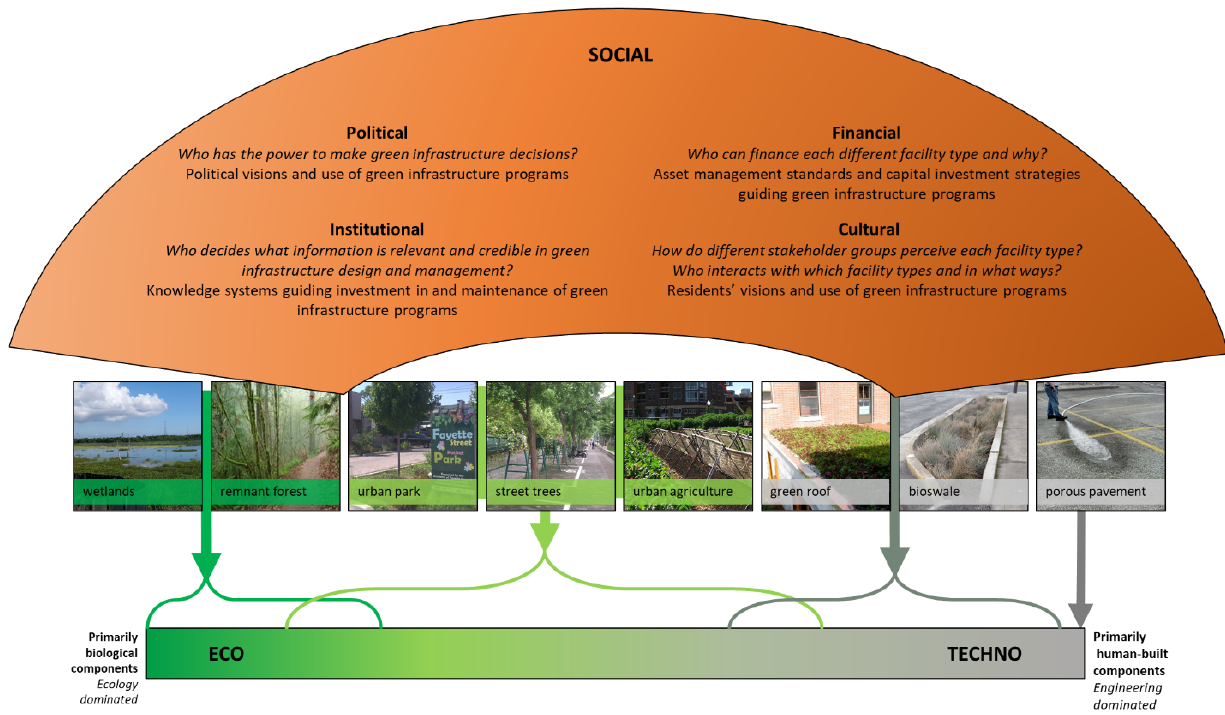
Figure 1. The eco-techno spectrum of GI organizes facilities by the proportion of the facility that consists of living, biological components vs. human-made, technological components. This forms a platform on which to connect salient social inter- actions with ecological and technological parameters, providing a unifying heuristic for operationalizing the SETS frame- work. The answers to specific social questions differ as one moves from ‘eco’ to ‘techno’ facility types, creating diverse social-institutional tensions across spectrum. Notes: Photo credits by Marissa Matsler (wetlands, urban park, street trees, bioswale), City of Portland (remnant forest, green roof), Create Commons (urban agriculture), and Milwaukee Metropolitan Sewerage District (porous pavement). Source: Adapted from McPhillips and Matsler (2018) and Matsler